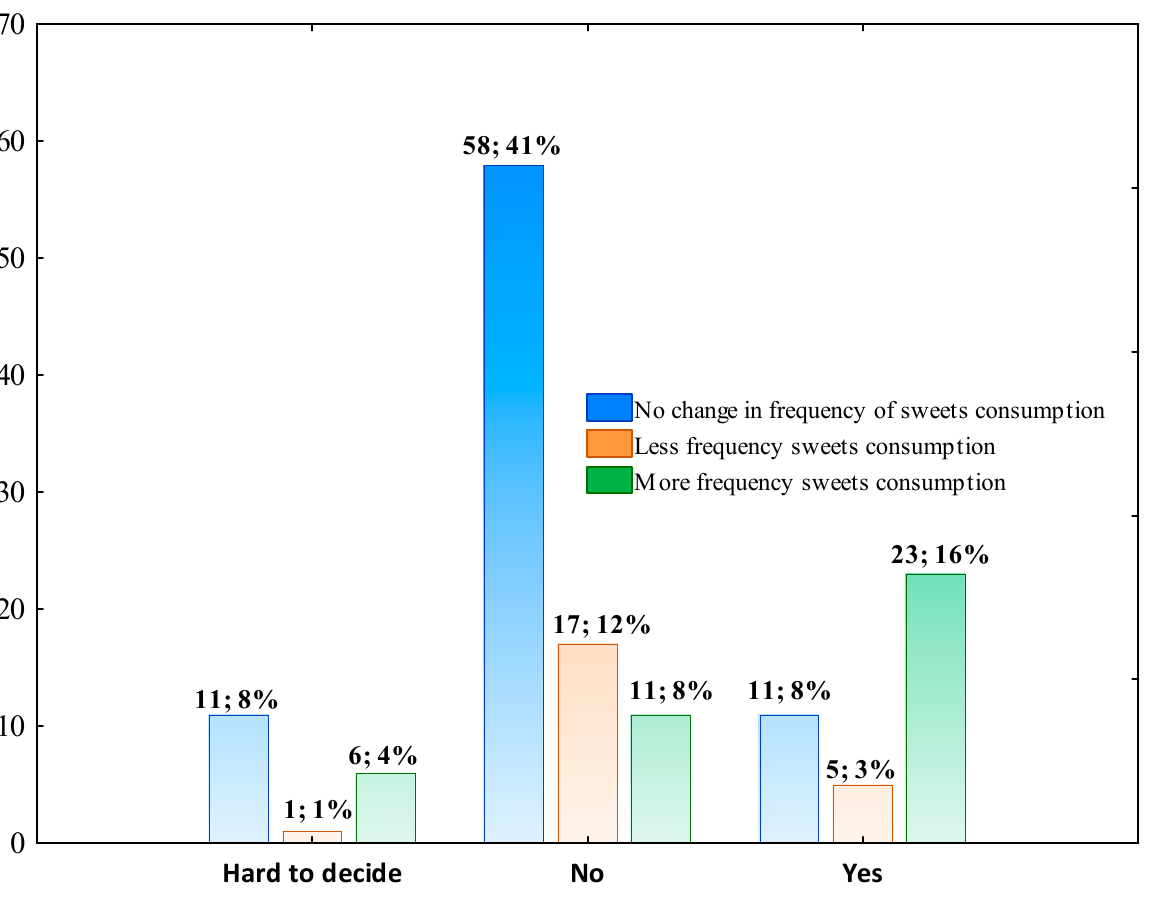
Table 4. Odds ratio for type of change in body mass (weight gain, weight loss or unchanged) dur- ing the COVID-19 pandemic by sweet consumption factor. Weight Loss